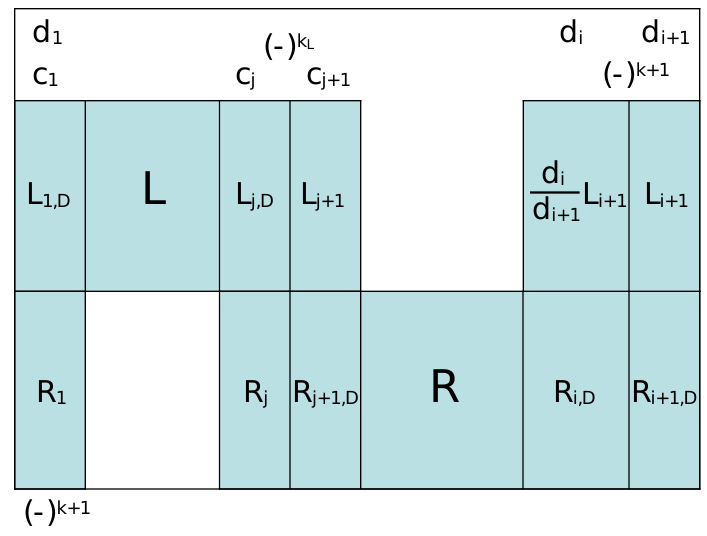
Figure 16 . Generic matrix con(cid:12)guration of 1-loop BCFW forward-limit terms labelled by i; j . which is the Narayana number N ( n (cid:0) 3 ; k +1). This number will be useful in section